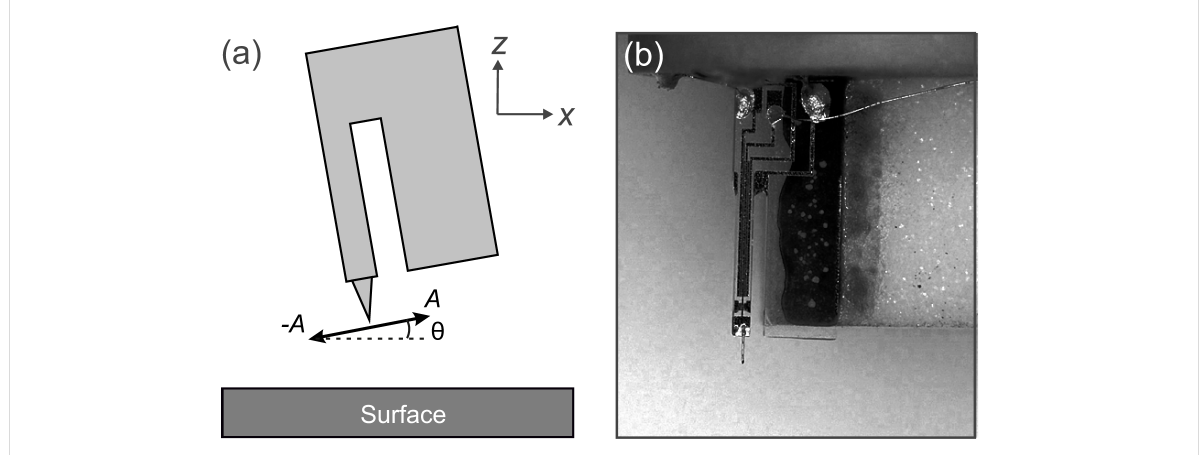
Figure 1: (a) Sketch of the qPlus sensor in LFM orientation with amplitude A and the sensor tilt θ . (b) Photograph of a qPlus sensor glued perpendicu- larly on a sensor holder shown by the white substrate.